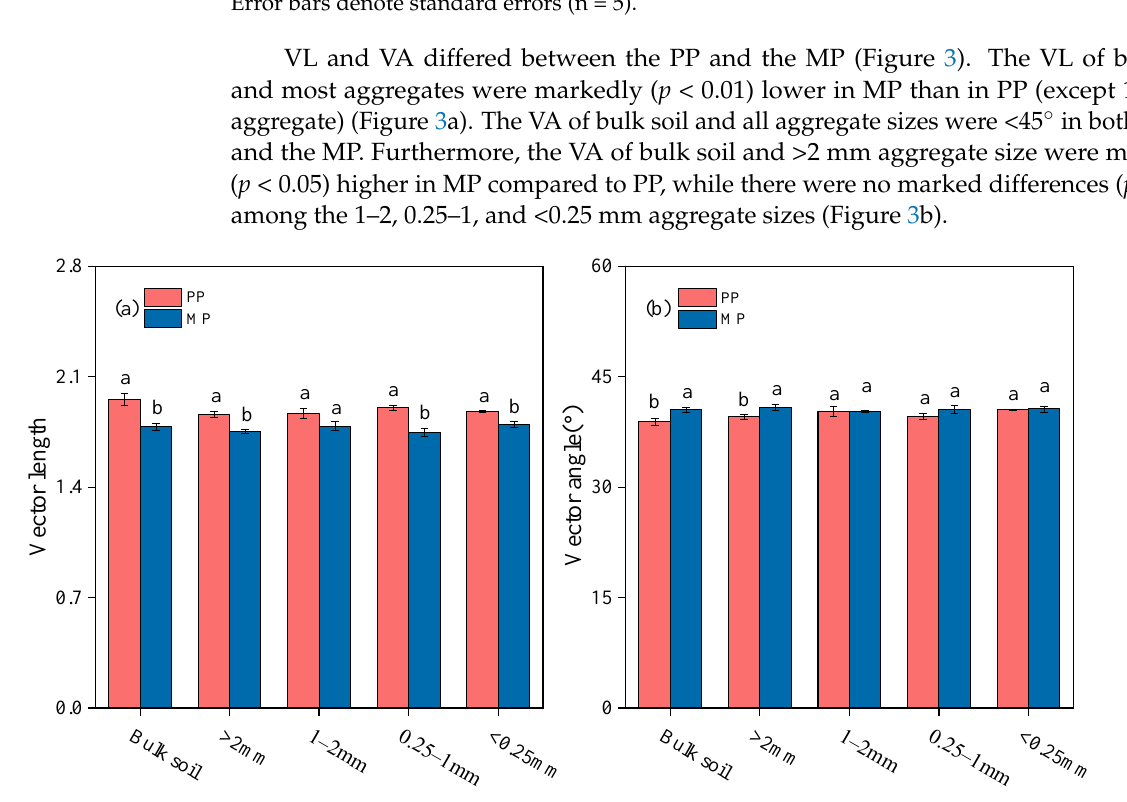
Figure 2. Soil extracellular enzymatic stoichiometry (EES) within bulk soil and aggregates in PP and MP ( a – c ). Different lowercase letters denote marked variations between the PP and the MP ( p < 0.05). Error bars denote standard errors (n = 5).